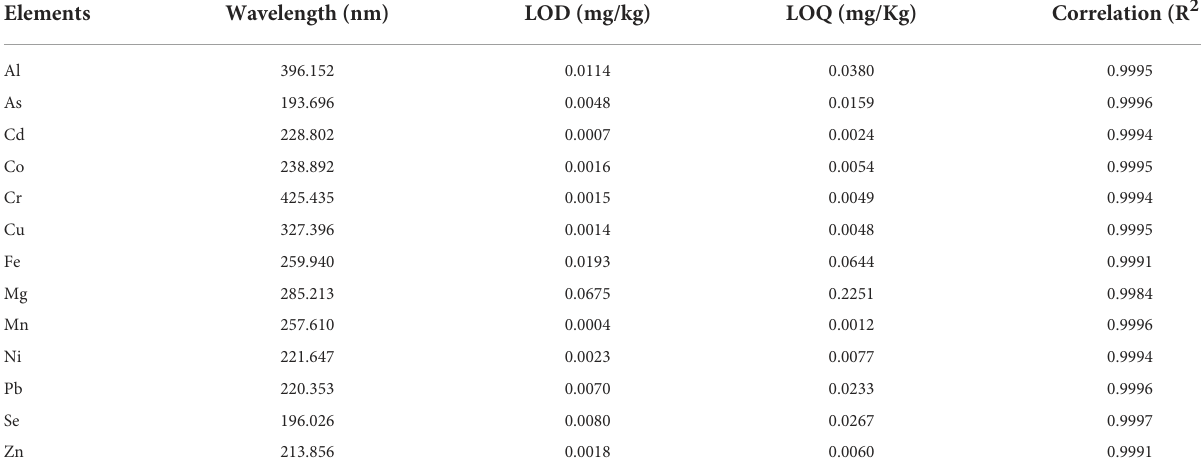
TABLE 1 The ICP OES operating conditions for